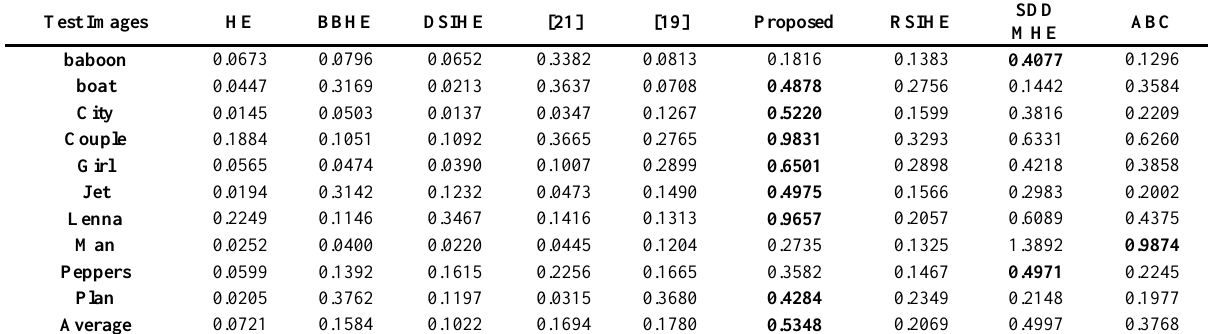
Table 1. Comparing various methods with AMBE.